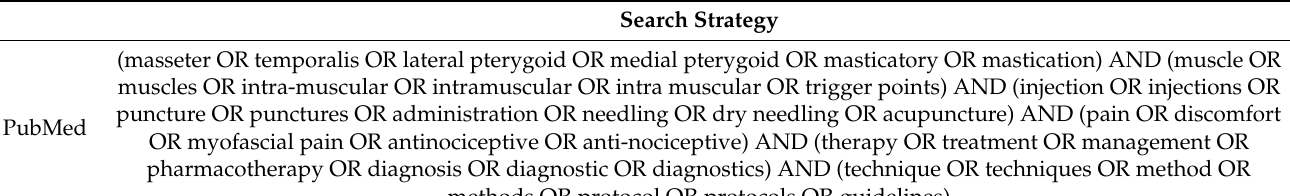
Table 1. Applied search